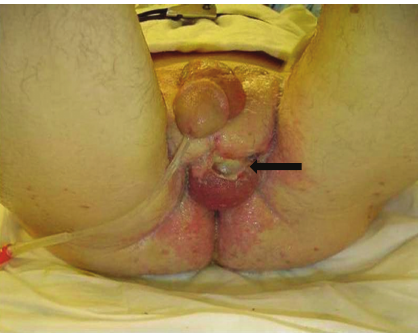
Figure 1: Fournier’s gangrene caused by Neisseria meningitidis : extensive perineal skin edema, erythema, and necrotic skin loss with exposed left testicle (black arrow).